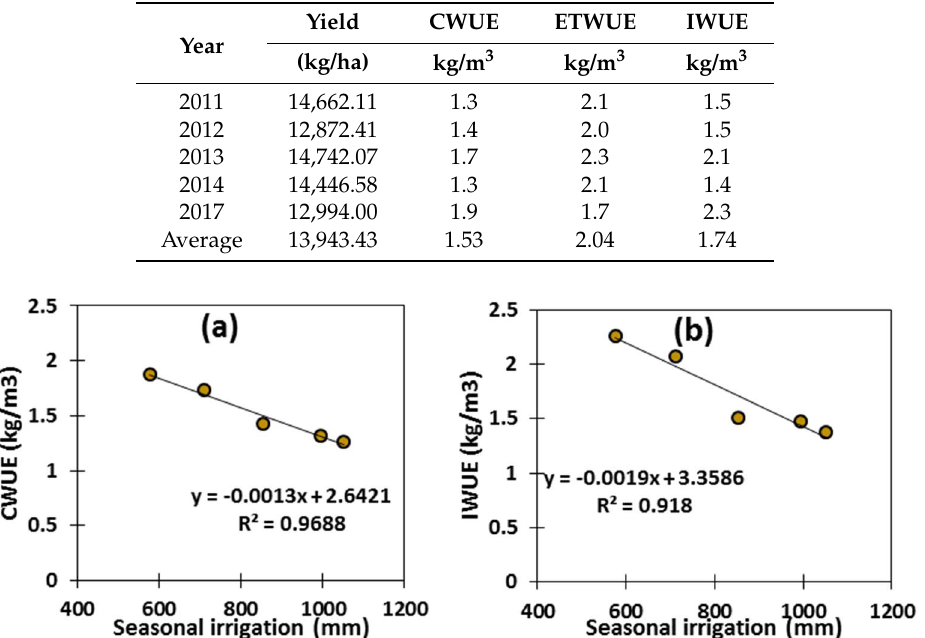
Table 4. Maize average grain yield and crop, evapotranspiration and irrigation water use efficiencies during five growing seasons. CWUE: crop water use efficiency; ETWUE: evapotranspiration water use efficiency; IWUE: irrigation water use efficiency.